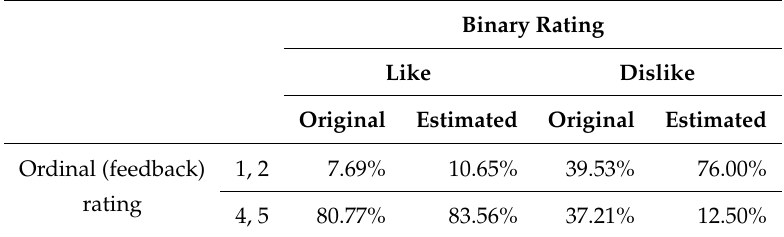
Figure 9. Frequency distributions of user feedback logs with respect to the two categories of binary ratings, like (empty) and dislike (filled), according to the ( a ) original ordinal ratings and ( b ) estimated feedback ratings. Table 5. Percentage of user feedback logs of two binary rating categories, like and dislike, when the original ordinal ratings and estimated feedback ratings were 1 or 2 and 4 or